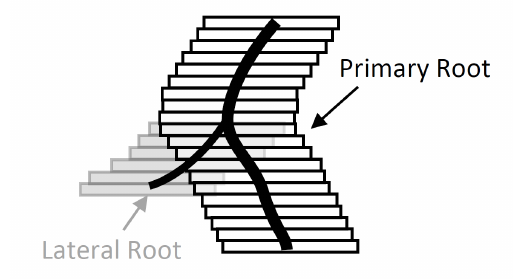
Table 1. Material properties used in this study